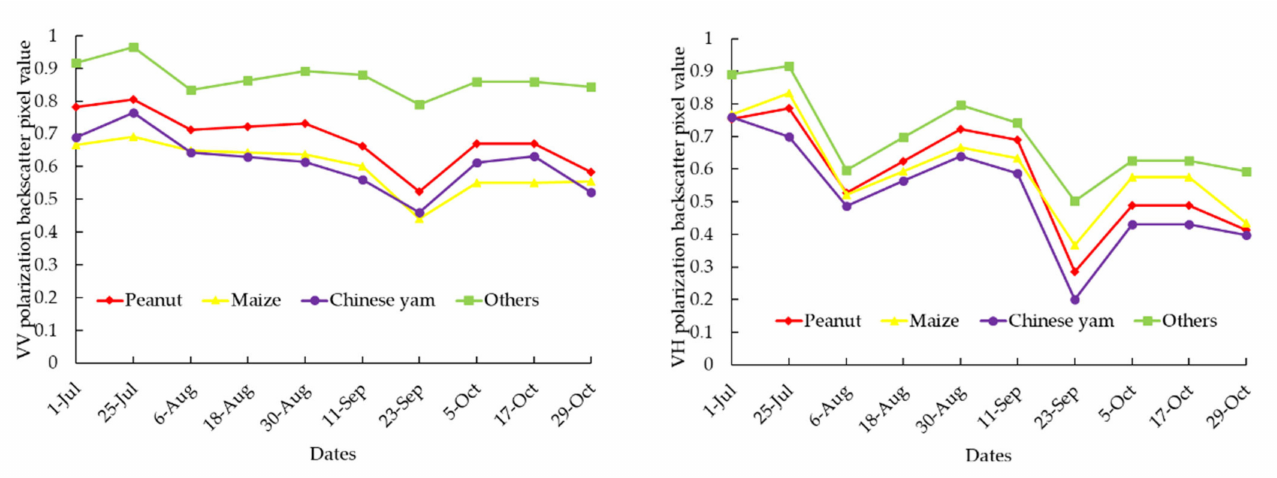
Figure 6. Temporal profiles of VV ( left ) and VH ( right ) polarization backscatter coefficients.